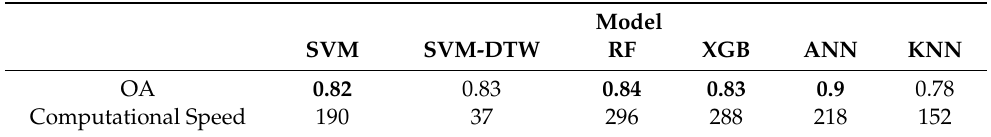
Table 4. Accuracy and computational time (samples/second) performance without considering customized